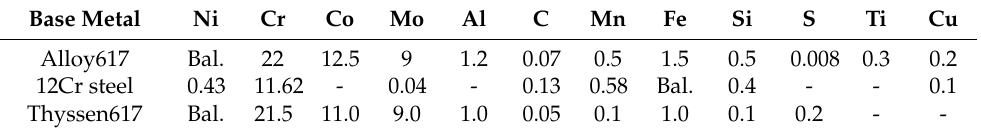
Table 1. Chemical compositions of base metals (wt. %).